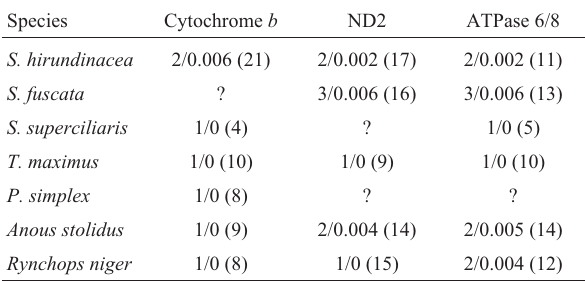
Table 3 - Number of haplotypes and values of nucleotide divergence in five species of terns and one species of black skimmer for each mtDNA gene sequences. The number of individuals tested is shown in